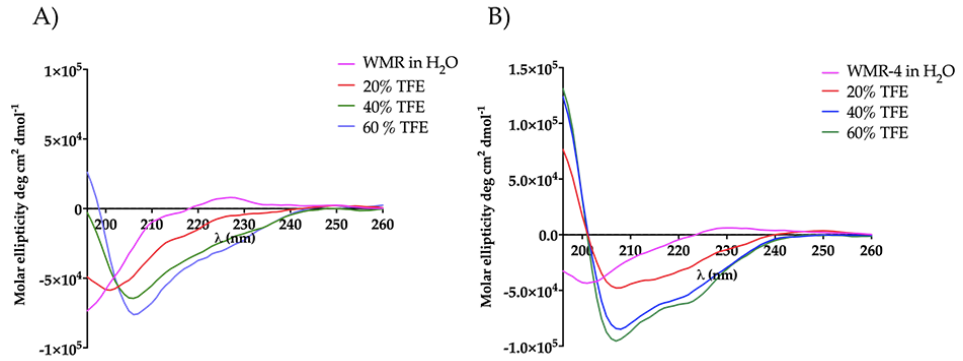
Figure 9. CD spectra of peptides WMR ( A ) and WMR-4 ( B ) in water and in presence of 20%, 40%, and 60% of TFE.